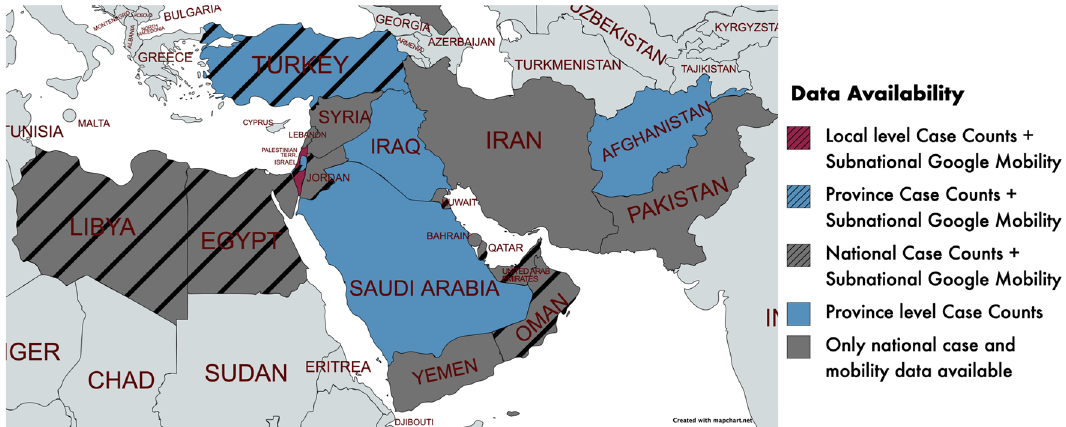
Figure 1. Map of countries in the study area, shaded to indicate data availability. Striped countries have sparse sub-national Google mobility data available, whereas non-striped countries have no sub-national Google mobility data. Countries in purple have urban-level COVID-19 case counts, ones in blue have provincial level case counts, while countries in dark grey only have national level COVID-19 case counts. Of our